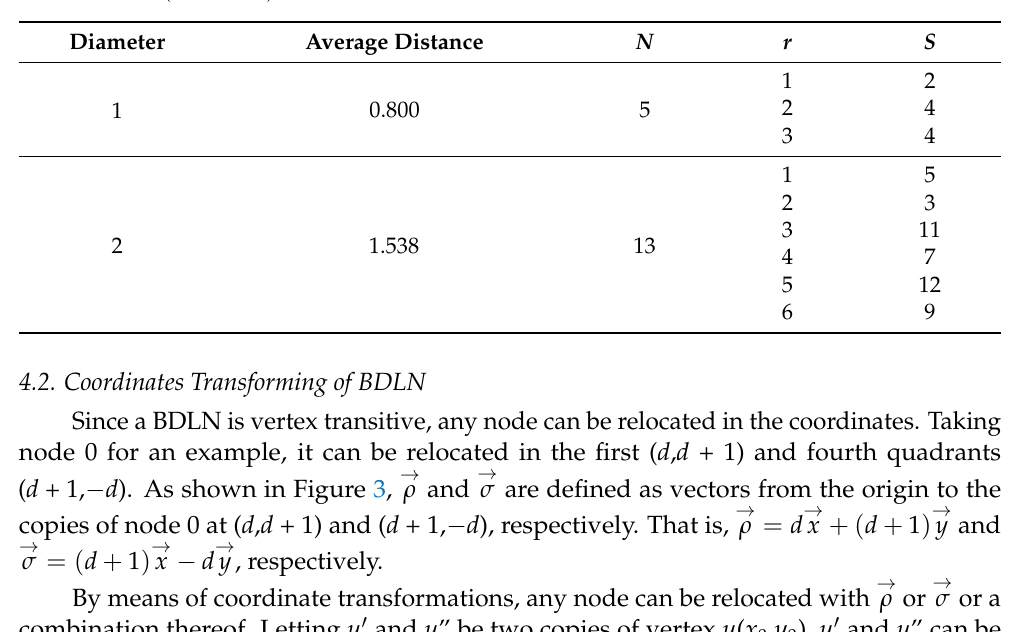
Table 1. BestG ( N ; ± r , ± s ) for diameter = 1,